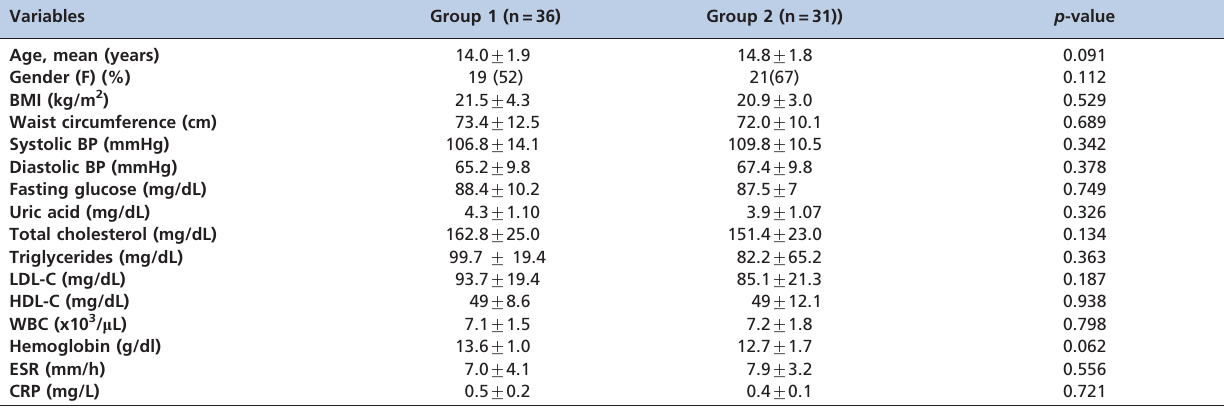
Table 1 - Baseline characteristics and laboratory findings of the study groups.